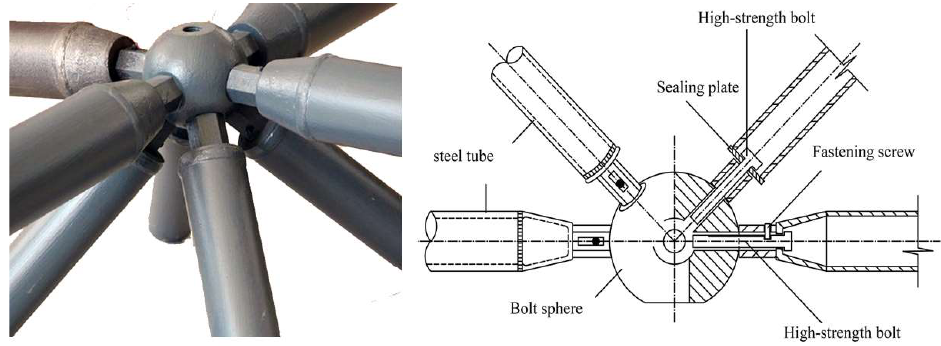
Figure 2. A schematic of a bolt–sphere joint.